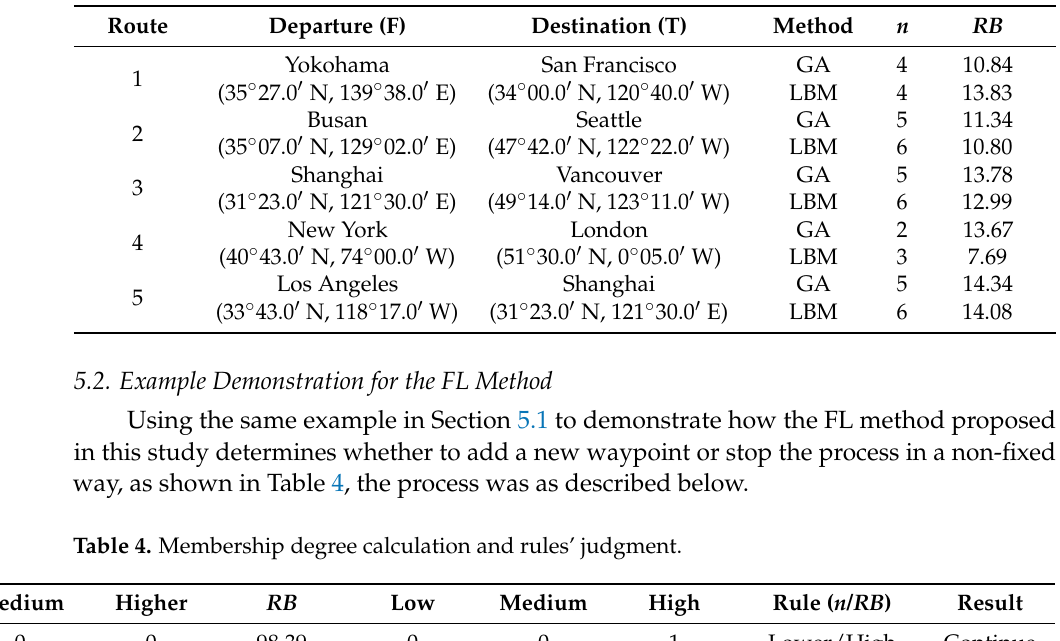
Table 3. Comparison of the GA method and LBM in the other five routes.